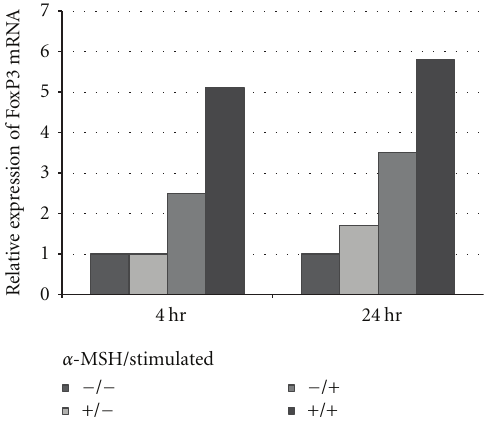
Figure 3: Real-time PCR analysis of FoxP3 after α -MSH treatment. The CD4 + T cells were isolated from draining lymph nodes, stimulated and treated with α -MSH as before. At 4 hours and 24 hours after treatment, message was isolated and analyzed by RT-PCR. Presented results are representative of two independent experiments showing the relative levels of FoxP3 message in CD4 + T cells. There is consistently about a 2 fold-higher amount of FoxP3 message in the α -MSH-treated (+/+) than in the untreated e ff ector T cells ( −